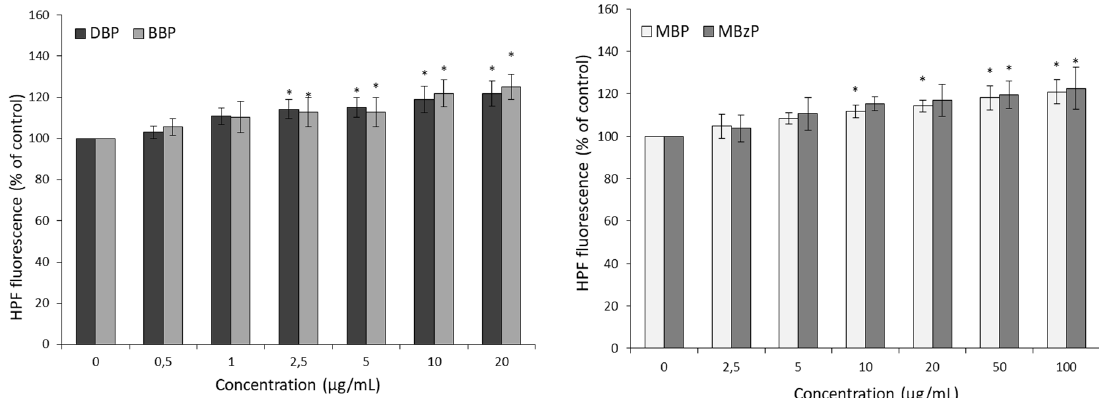
Figure 3. Changes in hydroxyl radical levels in control erythrocytes and in erythrocytes incubated for 6 h with DBP, BBP, MBP, and MBzP used at concentrations ranging from 0.5 to 100 µg/mL. (*) p < 0.05.